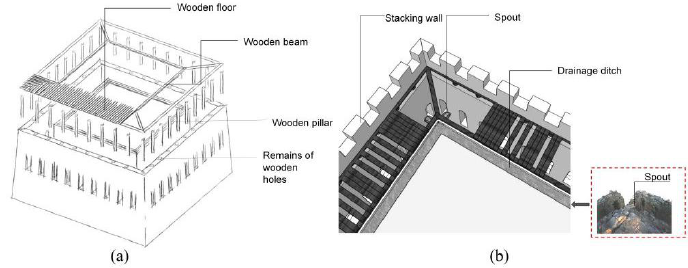
Figure 4. Restoration diagram of floor structure: ( a ) The restoration diagram of the brick-wood structure; ( b ) The brick-wood structure was placed on the top of corridor with the shape of " 回 ".